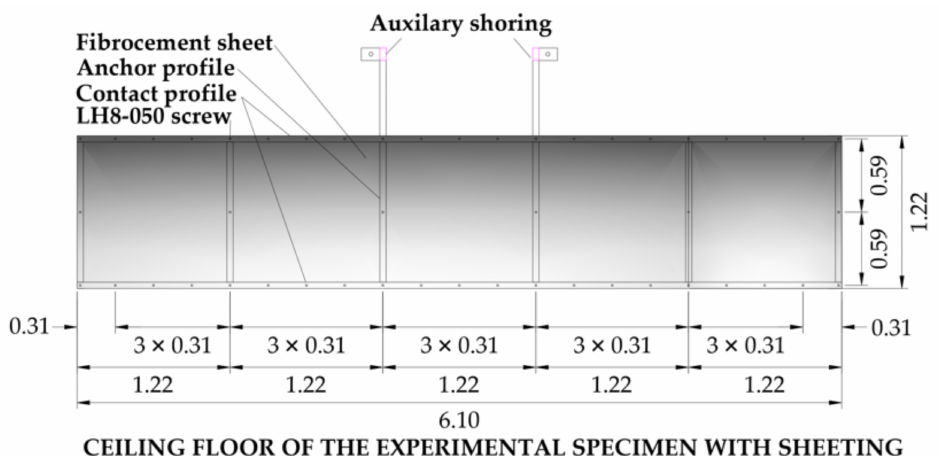
Figure 4. Ceiling of the experimental